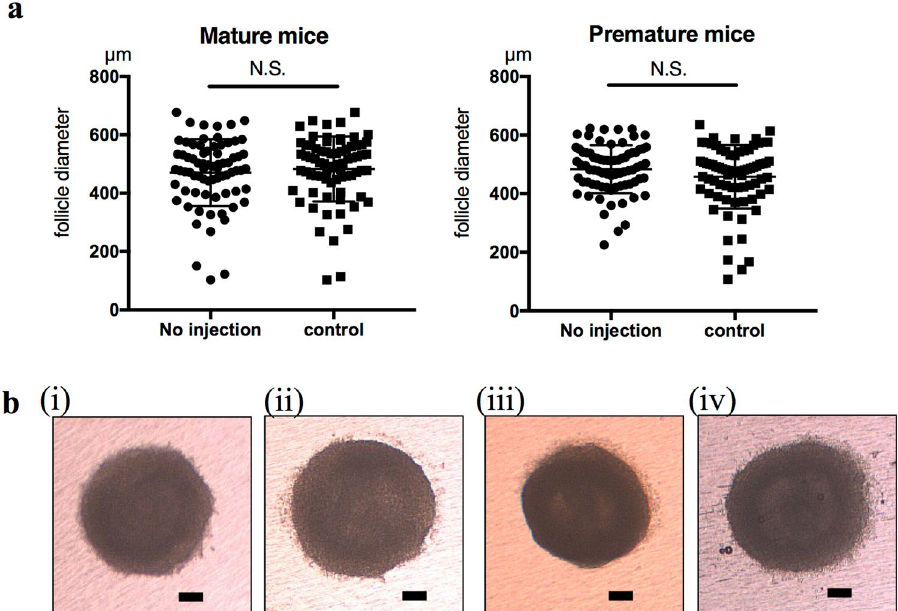
Figure 2. Follicle growth in no injection and control groups. ( a ) The diameter of cultured follicles did not significantly differ between follicles in the no injection group and negative control siRNA-injected follicles in both mature (left) and premature (right) mice. The diameters of mature mice follicles were 470.4 ± 114.8 µm (n = 73) in the no injection group and 482.8 ± 111.3 µm (n = 74) in the control group. The diameters of premature mice follicles were 483.8 ± 81.99 µm (n = 75) in the no injection group and 457.5 ± 108.7 µm (n = 76) in the control group. ( b ) Representative pictures of follicles after 12 days of in vitro culture. (i) Mature mouse follicle of the no injection group, (ii) mature mouse follicle of the control group, (iii) premature mouse follicle of the no injection group, and (iv) premature mouse follicle of the control group. Scale bars,